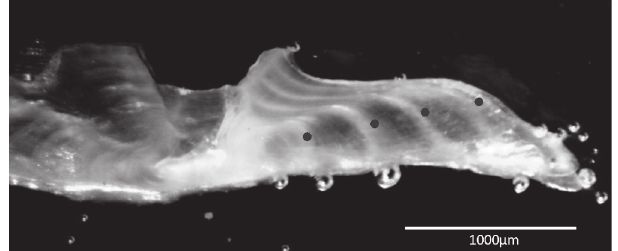
Fig. 2. Transverse section of an otolith of a 4+ year-old dusky grouper ( Mycteroperca marginata ) collected in the study area. The photograph was taken under a stereomicroscope (20x) and reflected light, and shows a clear differentiation between opaque (white) and translucent (dark) growth bands.